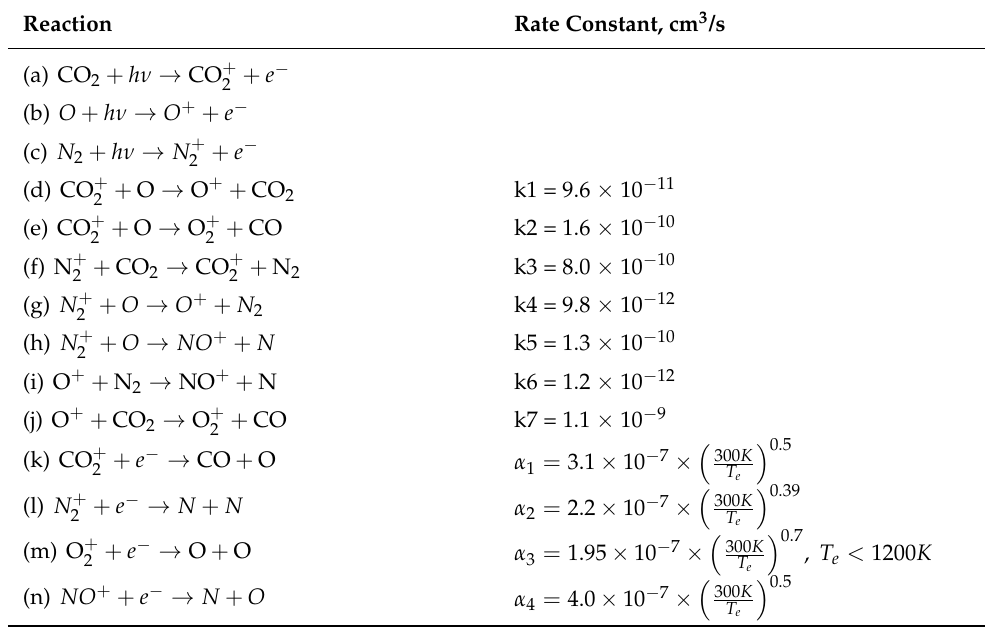
Table 1. The reaction equations and their reaction rates used in the present model